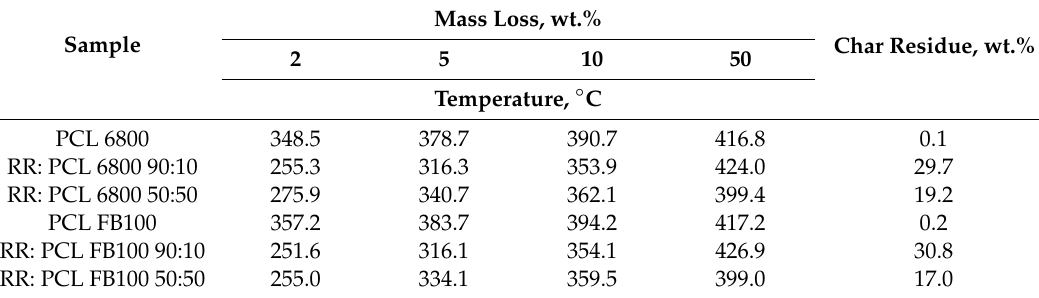
Figure 7. TGA and DTG curves for the composites of RR modified with (left side) Capa™ 6800 and (right side) Capa™ FB100. Table 4. Results of thermogravimetric analysis of the RR / PCL